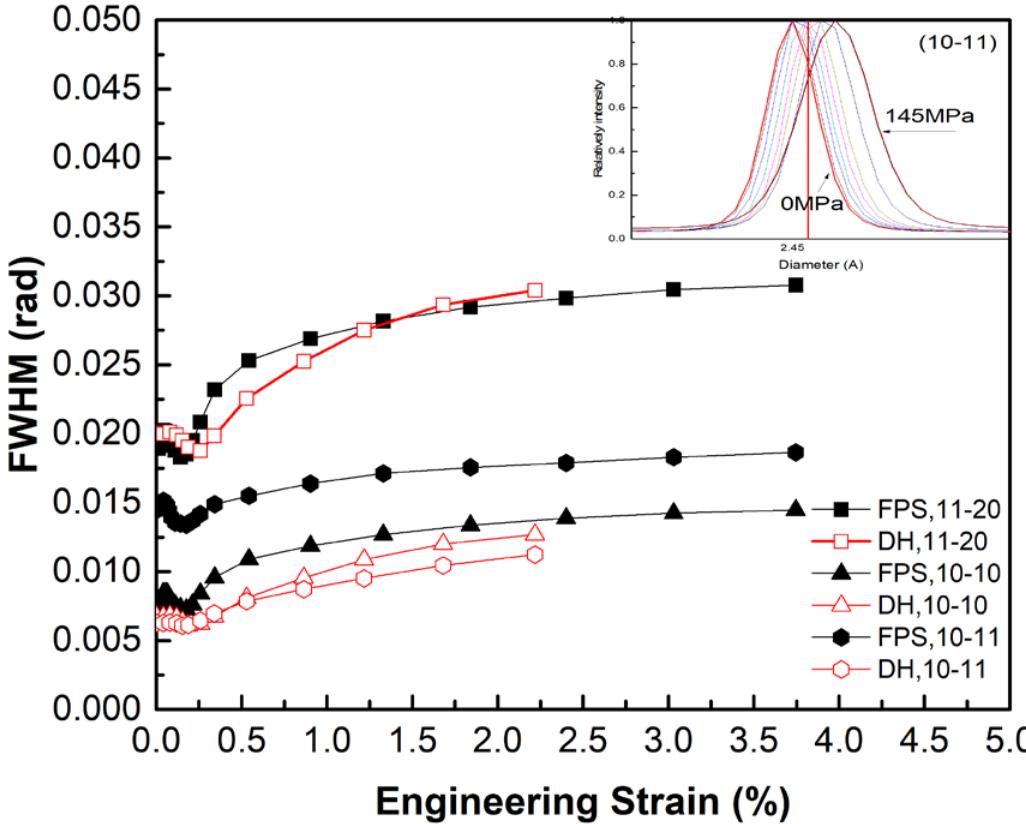
Figure 9. The evolution of the full width at half maximum (FWHM) of the {1010}, {1011}, and {1120} peaks as a function of strain. The inset shows the shape and position change of the {1011} peak of the DH specimen at different stress levels.